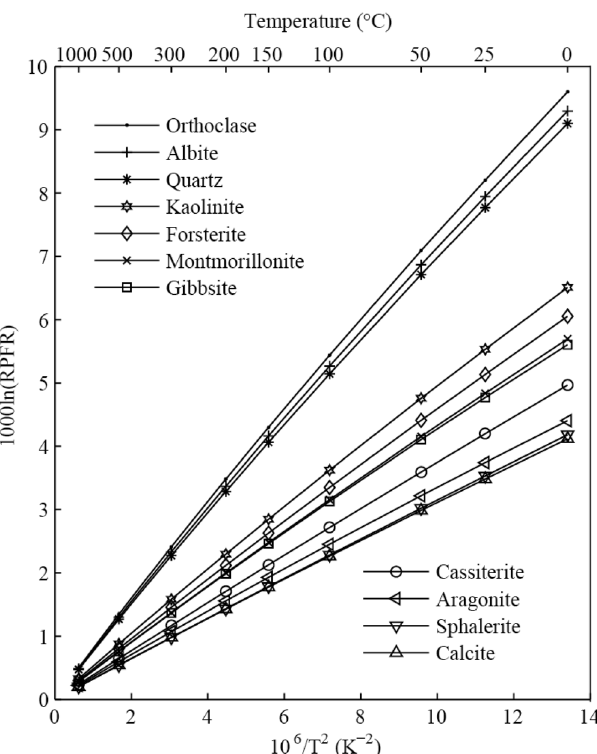
Figure 5. The graphical representation of 10 3 ln(RPFR)s for different Ga-bearing minerals vs temperature. The basis set of B3LYP/6-311 + G(d) is used for all